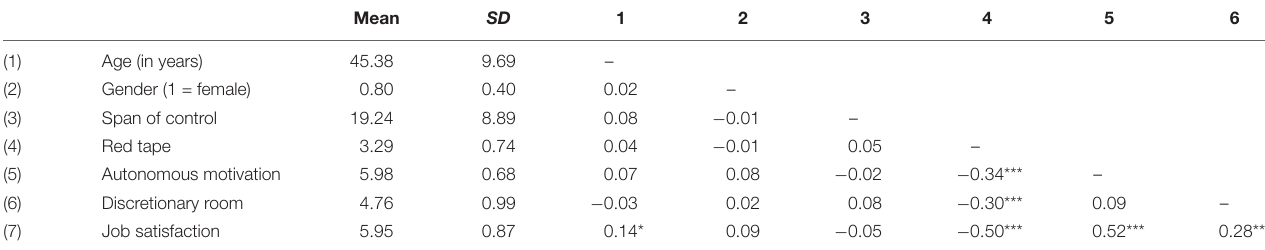
TABLE 2 | Descriptive statistics and correlations.